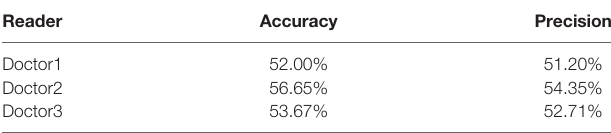
TABLE 1 | The results of the visual evaluation between the synthesized and original FP-Dyn